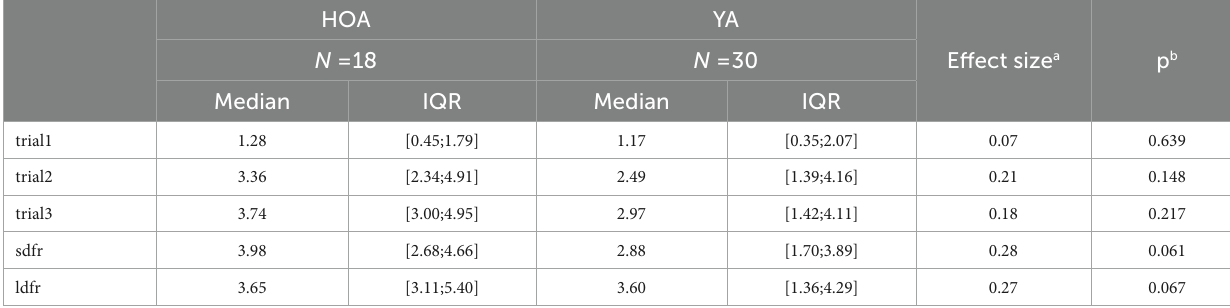
TABLE 2 The median and interquartile range of the semantic clustering